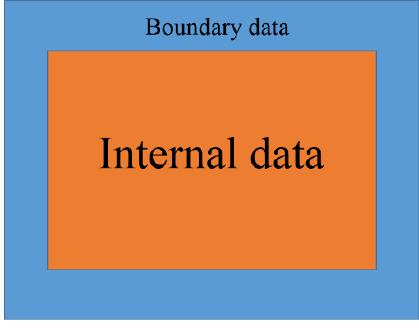
Figure 6. Boundary communication hiding.